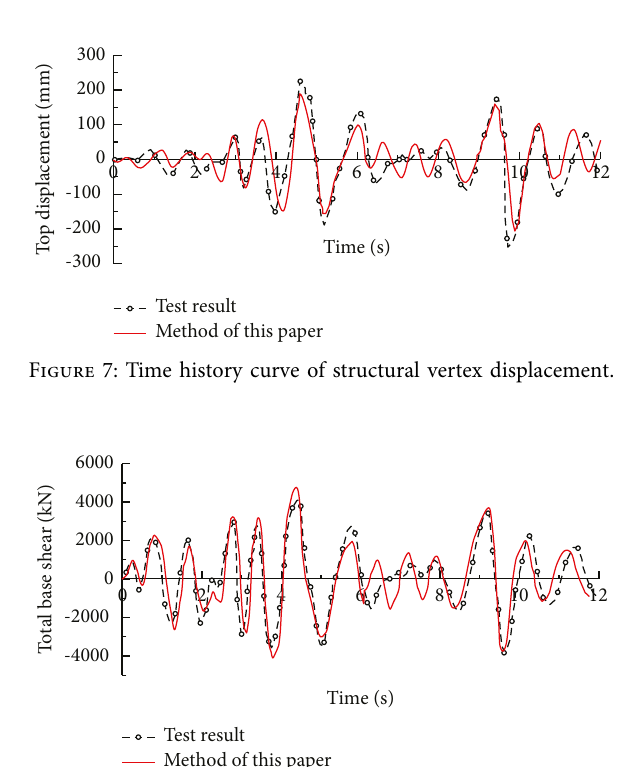
Figure 6: Comparison of total structural weight.